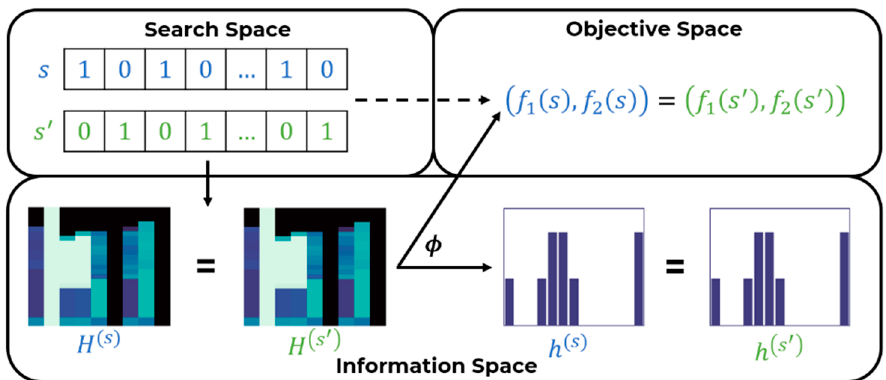
Figure 5. Search space, information space and objectives.